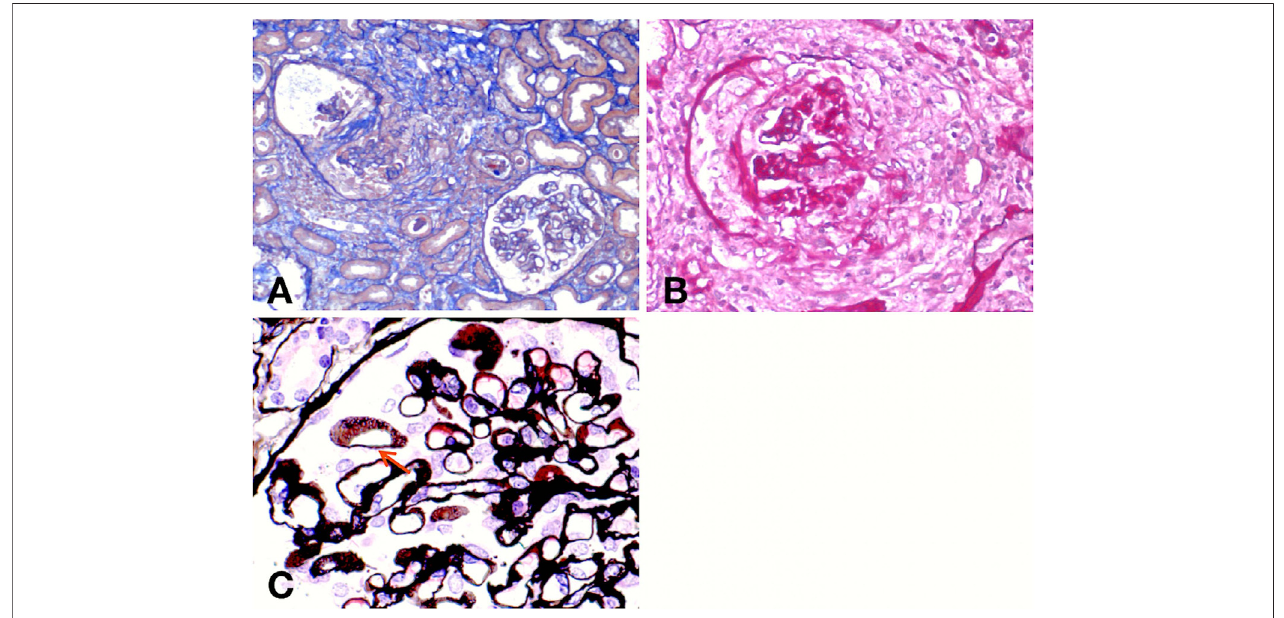
FIGURE 1 | Light micrographs. Masson (A) and periodic acid – Schiff (PAS) (B) staining show crescent formation, fragmented capsule walls, and interstitial in fl ammatory in fi ltration. Periodic Schiff-methenamine silver (PASM) (C) staining reveals the formation of short subepithelial spikes (red